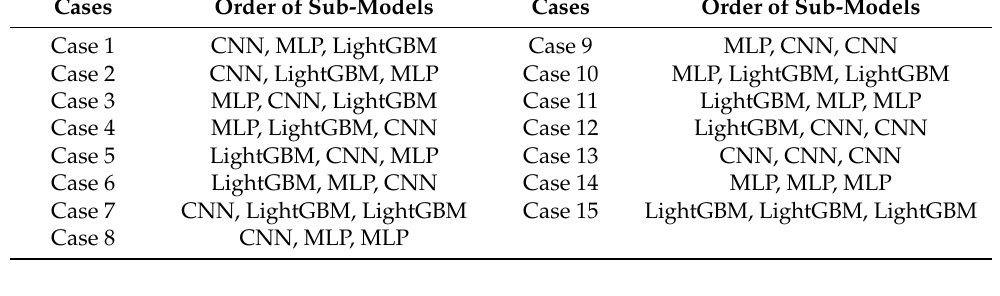
10 of 16 Table 1. Results of ensemble models with different parameters. Cases